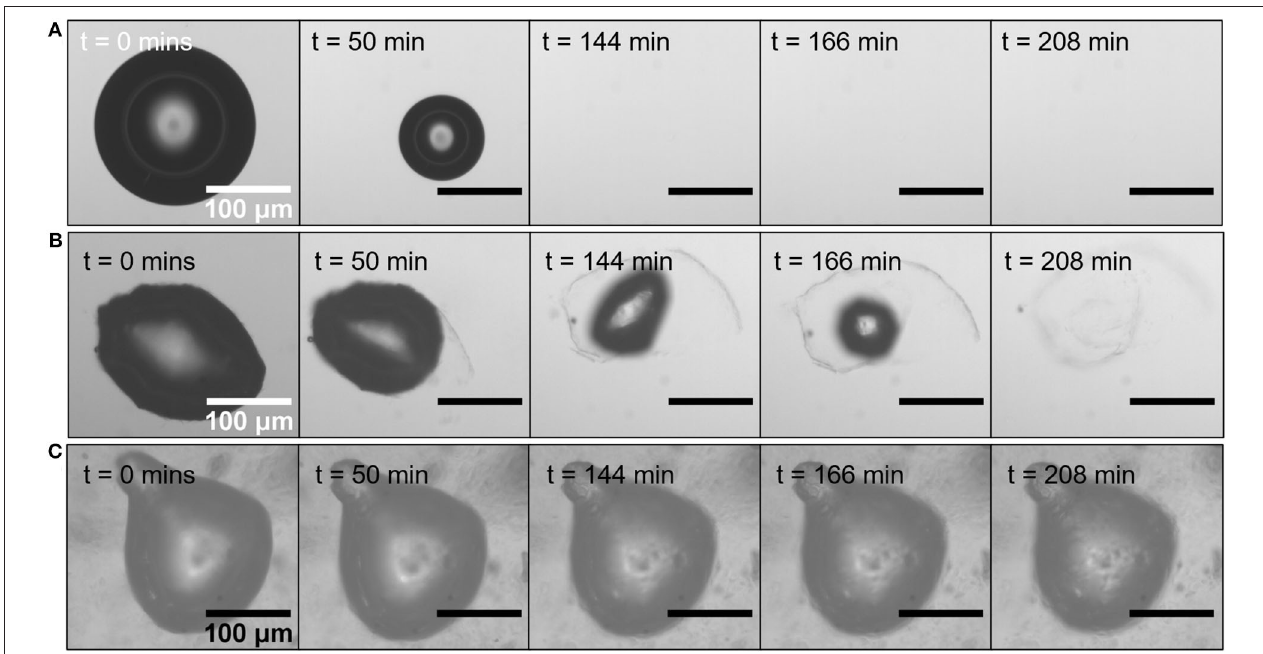
FIGURE 2 | Image sequences of evolution of air bubbles at 25 ◦ C. (A) A bare bubble quickly dissolve in sunflower oil. (B) Bubble coated by synthetic waxes in sunflower oil. The solid interfacial layer unfold leading to bubble dissolution. (C) Bubble inside an oleofoam remains stable over the same timescale. Reproduced from reference ( Saha et al., 2020) with permission from